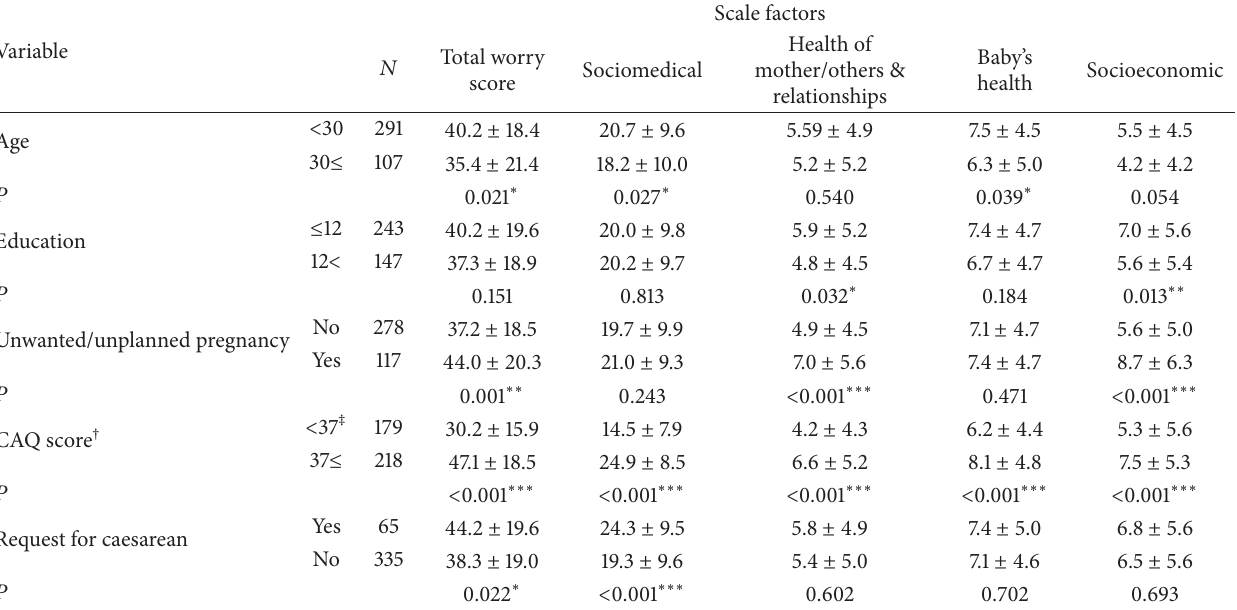
Table 5: Means of the 22-item Farsi Cambridge Worry Scale scores based on sociodemographic variables.